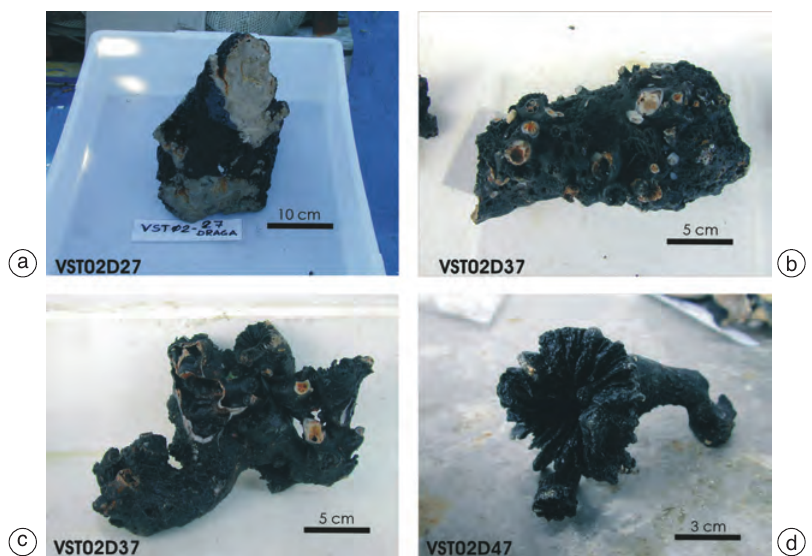
Fig. 12a-d. Selected samples of framestones. An evolution from corals d) and c) that are filled by sediments and then lithified b) and a) is envisaged for their formation.